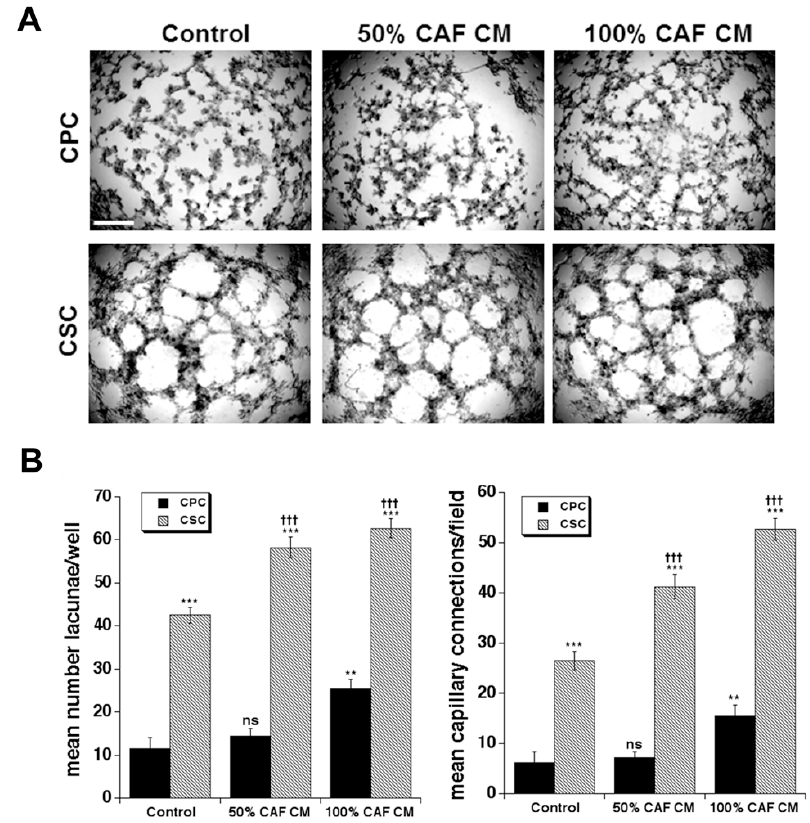
Figure 3. CAF conditioned medium stimulates the vascular-like morphology (VM) of both CSCs and CPCs grown on 90% Matrigel:10% Collagen I. ECM composition modifies the effect of CAF CM on vasculogenic mimicry in CPCs and CSCs. Cells were grown on 90% Matrigel: 10% Collagen I and after 24 h to permit their adherence the cultures were incubated with CAF conditioned medium and the cells cultured an additional 5 days and VM measured as described in Materials and Methods. ( A ) Representative microscopic images of growth morphology of CPCs and their derived CSCs cultured on organotypic cultures composed of 90% Matrigel:10% Collagen I for 5 days with their growth medium or with either 50% or 100% of the CAF conditioned medium. Scale bar represents 50 µm for all images. ( B ) After 6 days in these growth conditions, vascular channel networks were analyzed as described in Material and Methods for mean number of lacunae per well (left panel) and mean number of capillary connections per field (right panel). Mean ± SEM from three independent experiments, ns, non significant, ** p < 0.01, *** p < 0.001 compared to the CPC control; ††† p < 0.001 CSCs compared to their control.